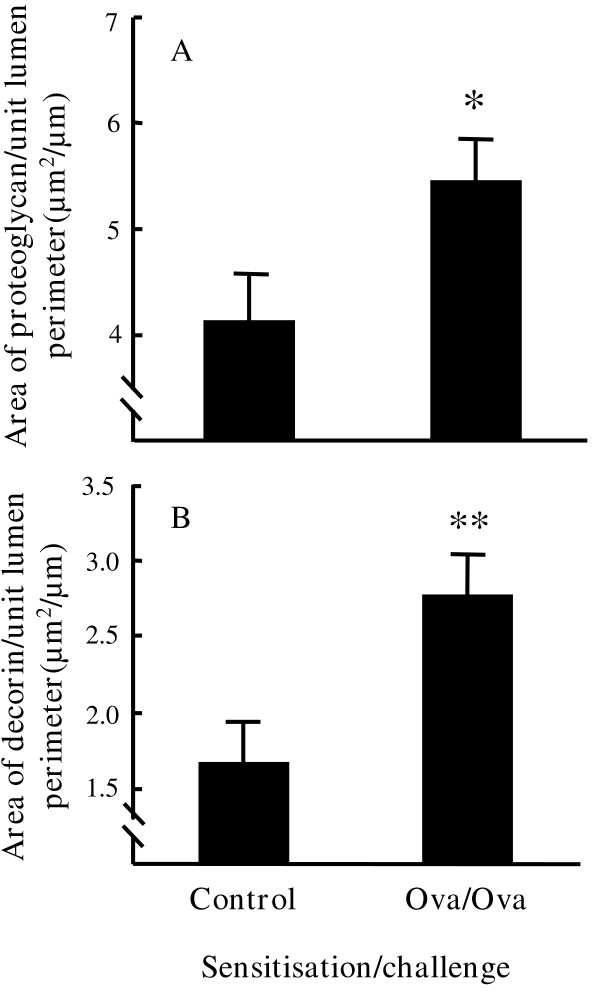
The effect of ovalbumin sensitisation/challenge on sub-epithelial total proteoglycans and decorin. (A) The area of sub-epithelial proteoglycan/unit lumen perimeter was quantitated using image analysis of Cupromeronic Blue stained sections. The numbers of mice/total airways analysed per group were: Control 9/32 and Ova/Ova 10/52. (B) The area of sub-epithelial decorin/unit lumen perimeter was quantitated using decorin immunostaining. The numbers of mice/total airways analysed per group were: Control 7/40 and Ova/Ova 10/70. * p < 0.05, ** p < 0.01.